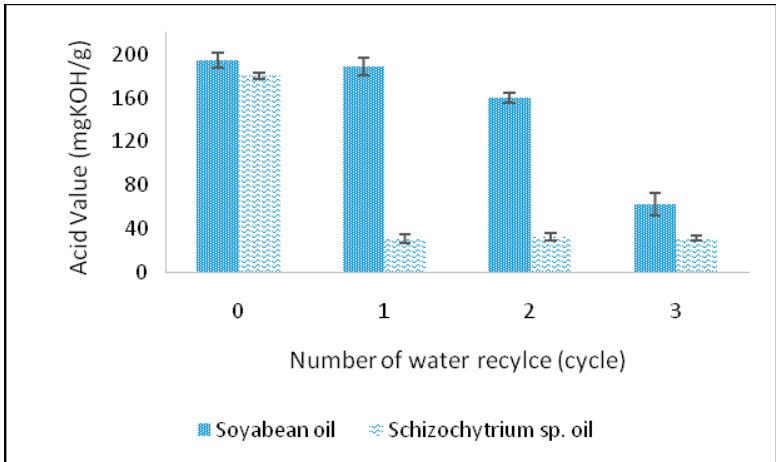
Figure 13. Effect of water recycle to the hydrolysis on soybean oil and Schizochytrium sp. oil (Reaction temperature = 95 °C, Water to oil ratio = 10:1 (w:w), 1% Sodiumdodecyl-sulfate based on oil weight, 1.4 mol/L sulphuric acid).